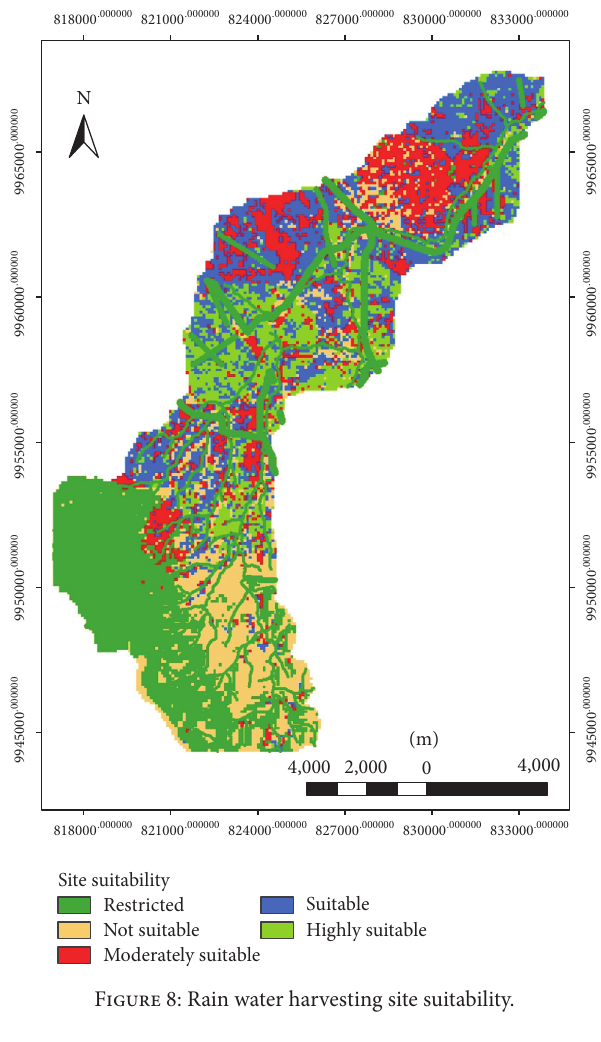
Figure 8: Rain water harvesting site suitability.